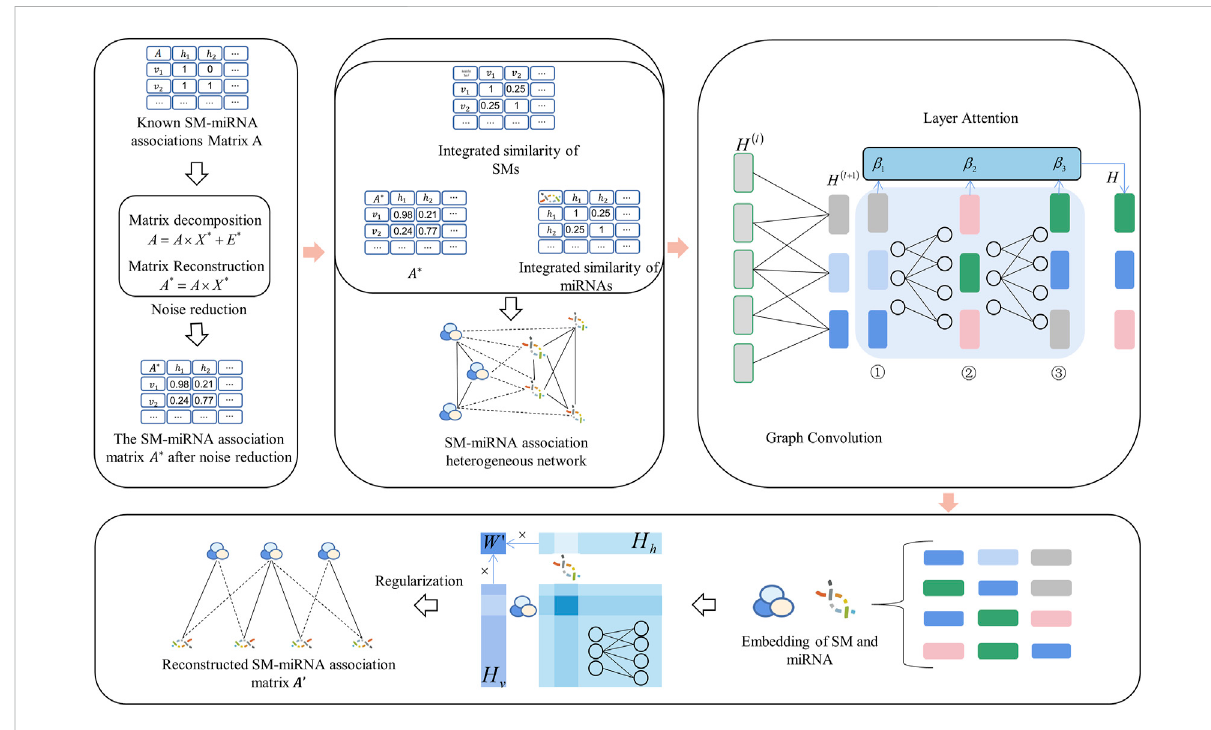
FIGURE 1 The fl ow chart of potential SM-miRNA association prediction based on GCNLASMMA. Firstly, the matrix decomposition is applied to obtain the newSM-miRNAassociations.ThenthenewSM-miRNAassociations,integratedSMsimilarityandintegratedmiRNAsimilarityareconstructedintoan SM-miRNA association heterogeneous network. Finally, a graph convolutional network with layer attention mechanism is applied to obtain the reconstructed SM-miRNA association